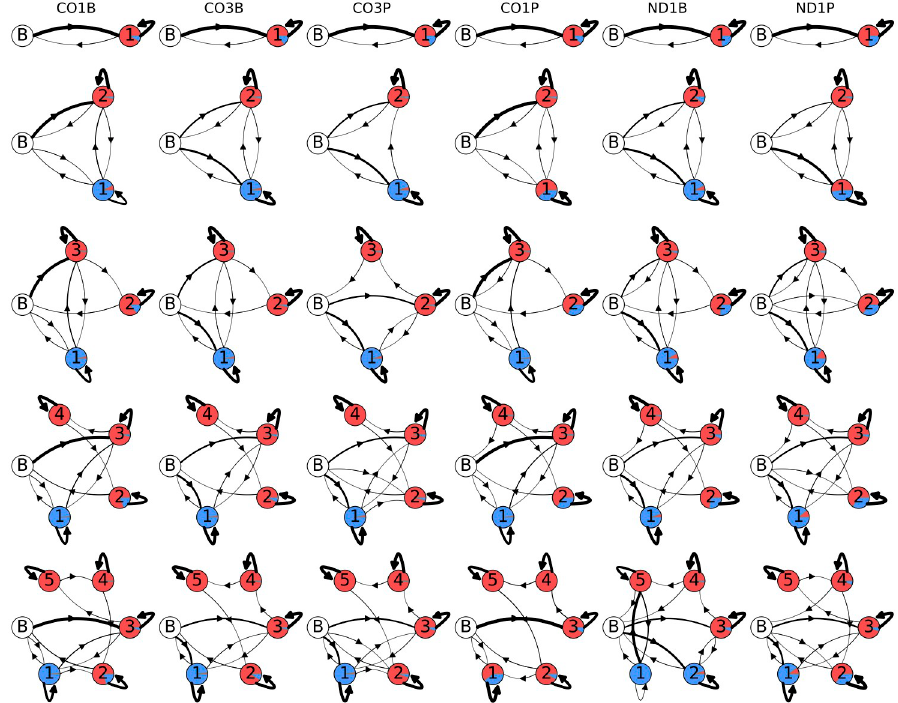
Fig 13. Unstructured model topologies. Post-training unstructured model topologies and emissions of U and A nontemplated tail addition to populations of 3’ mRNA ends of the mitochondrial genes indicated at the top. Models go from simplest in the top row (G1, 1 state) to complex at the bottom (G5, 5 states). The areas covered by the separate colors in each state circle are proportional to their emissions: uncolored circle labeled ‘B’ indicates the beginning/end state, red is single adenine addition, and blue is single uracil addition. The thickness of the arrows connecting states is proportional to the transition probability.